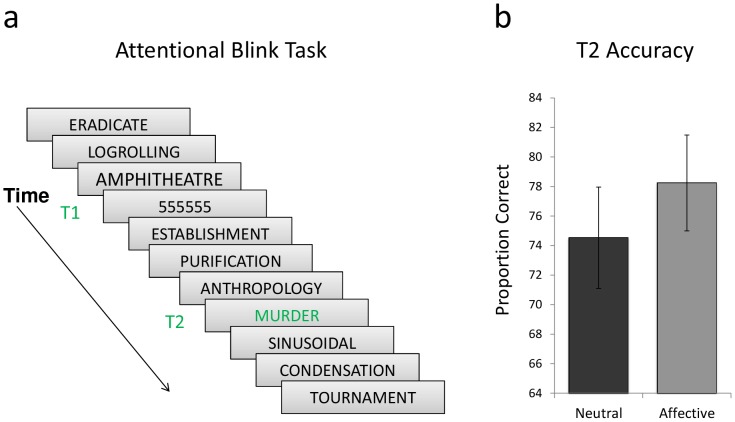
Example of the attentional blink task and behavioral results.a) Within a rapid stream of stimuli occurring every 100 ms, participants must identify two target words (in green). For each subject, T2 occurred at one of 4 possible lags (200, 400, 600 or 700 ms) after the presentation of T1. The lag for each individual, was established using a practice task prior to the MEG task, and was based on the lag at which ∼65% accuracy was achieved. b) Accuracy for emotionally neutral and emotionally salient T2 words.